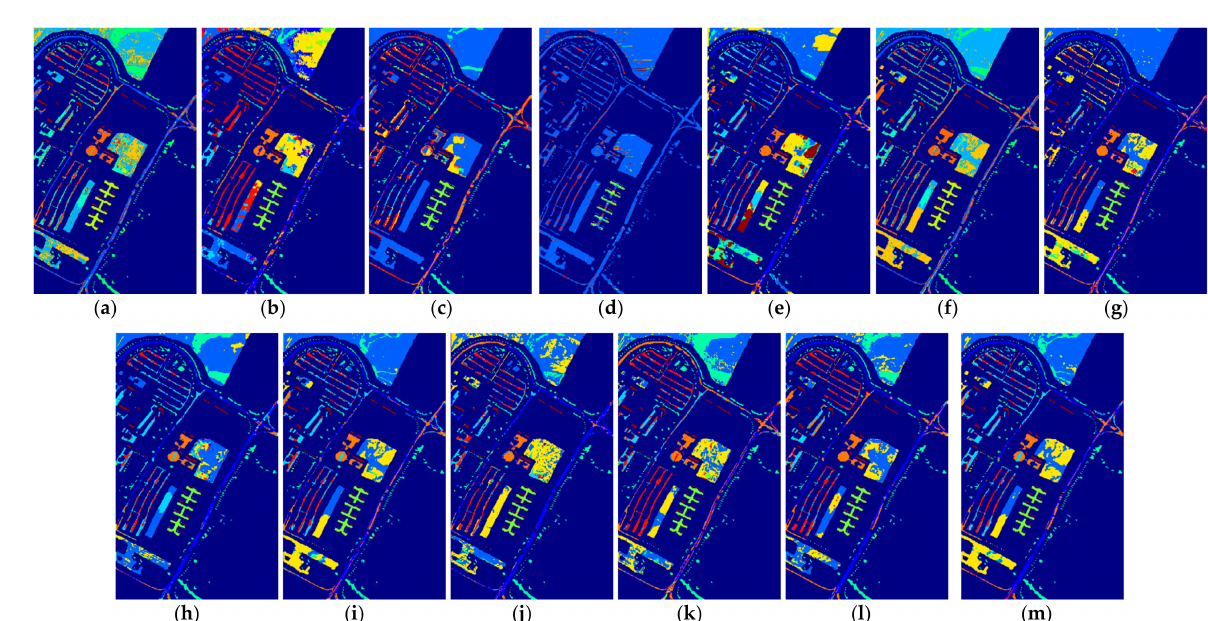
Figure 8. The classification maps of all methods with five samples on PaviaU dataset. ( a ) SVM; ( b ) SS-LapSVM; ( c ) 3D-DENSEnet; ( d ) 3D-Gan; ( e ) SS-CNN; ( f ) 3D-CNN; ( g ) 3D-CNN k - means ( h ) 3D-CNN ours ; ( i ) 3D-CNN hardlabel ; ( j ) SSRN; ( k ) SSRN k - means ; ( l ) SSRN ours ; ( m ) SSRN hardlabel .